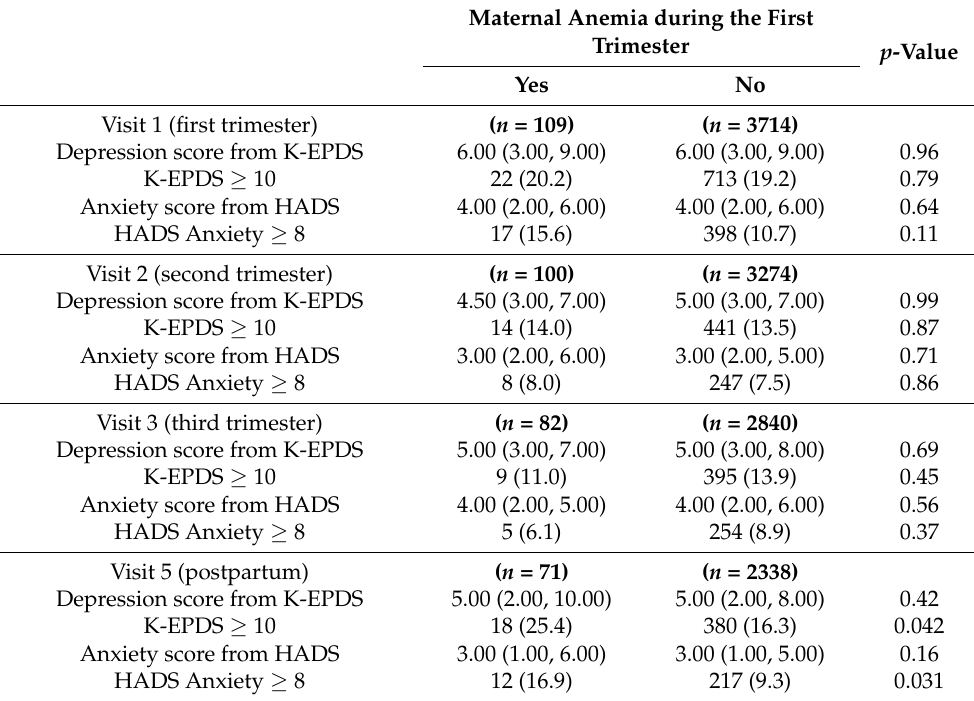
Table 4. Comparison of mental health during pregnancy and postpartum between participants with and without anemia during the first